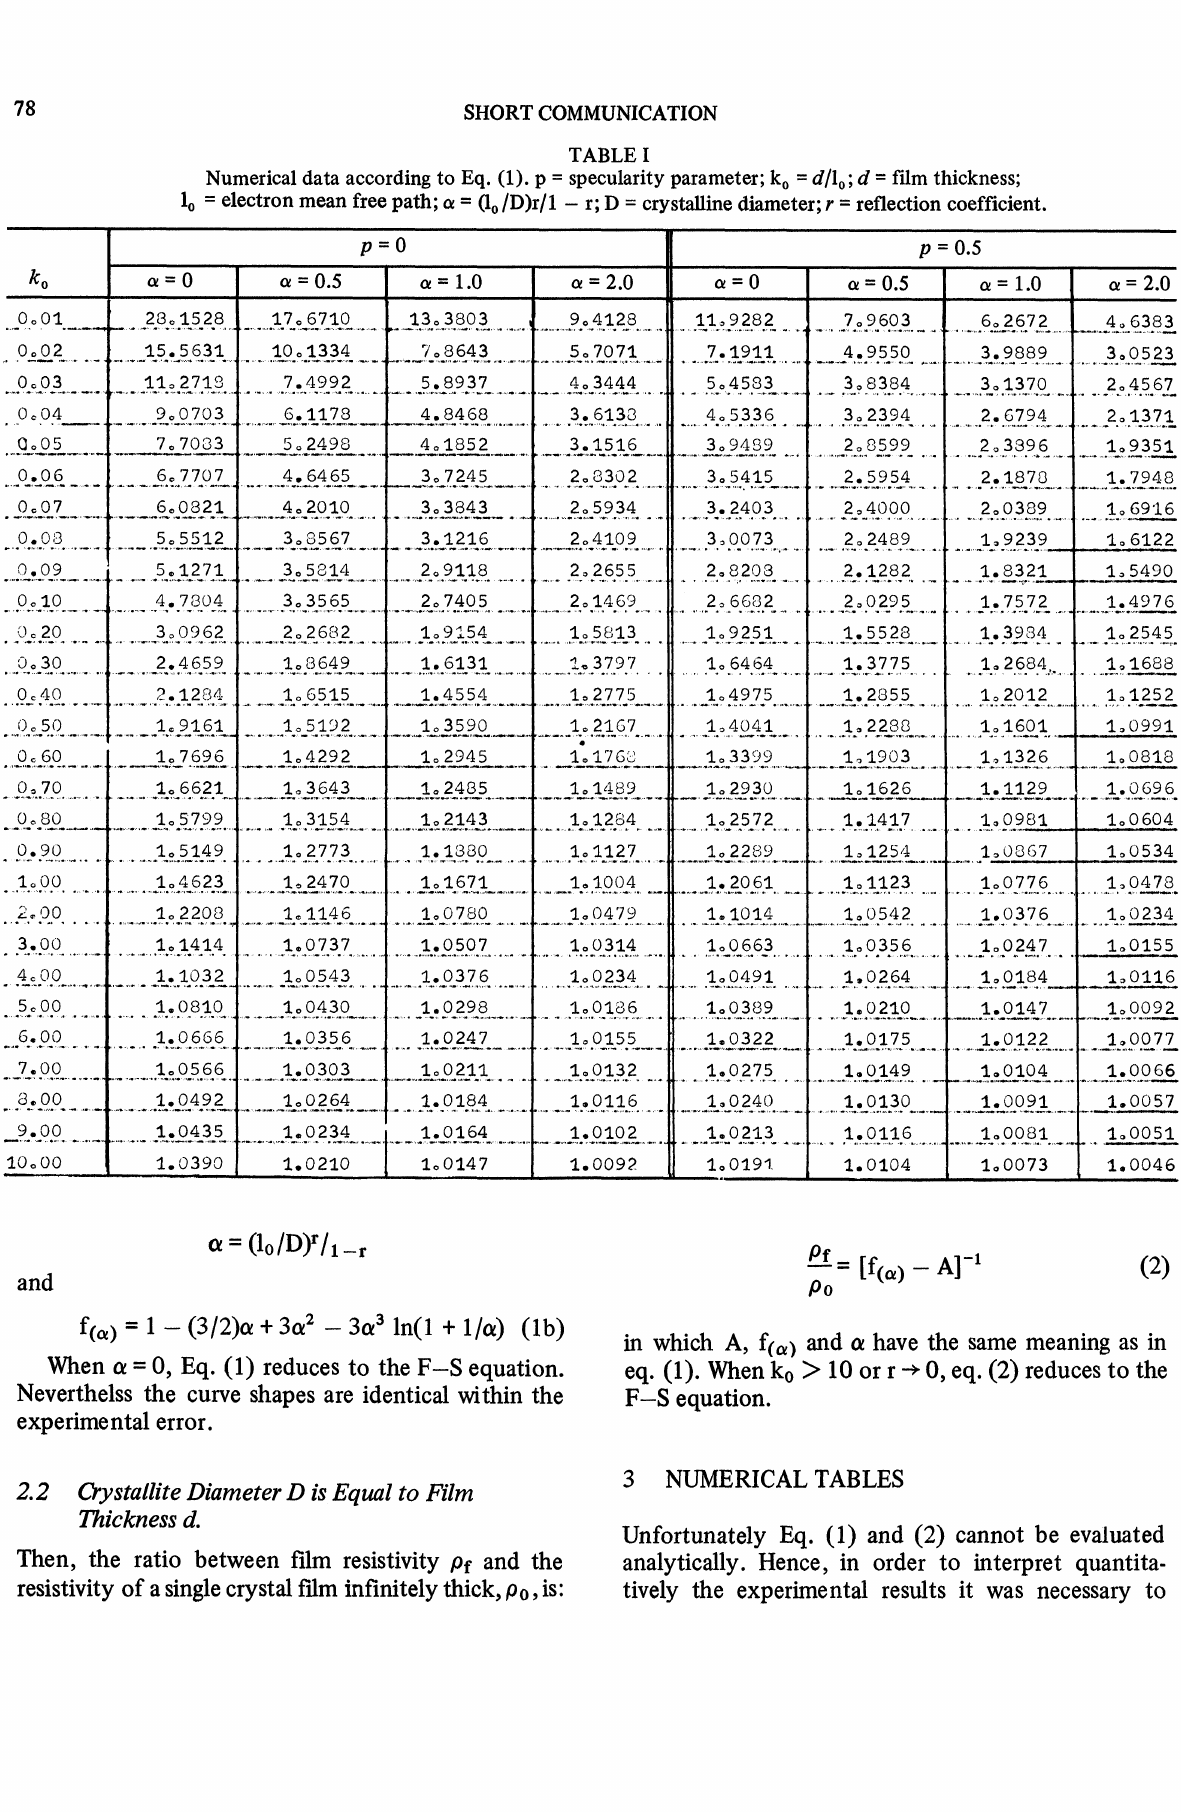
Numerical data according to Eq. (1). p specularity parameter; k d/lo; d film thickness;